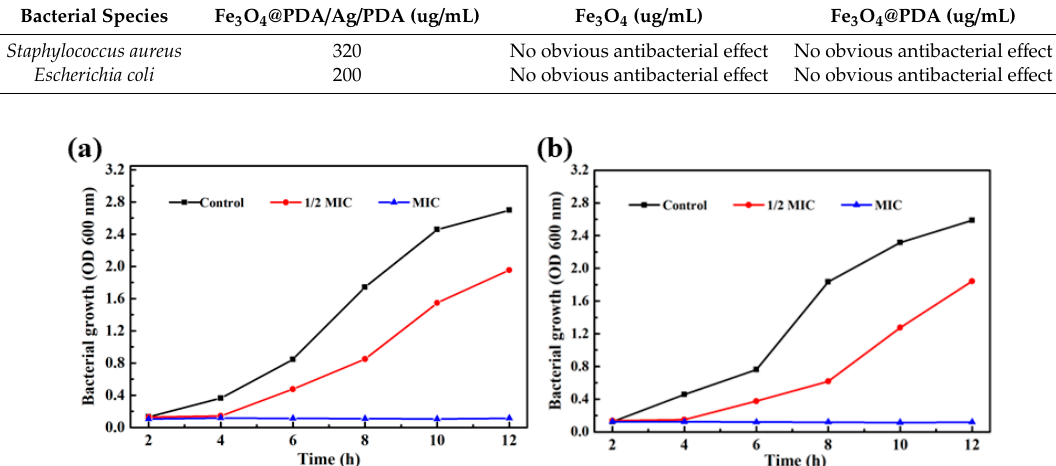
Table 1. Minimum inhibitory concentration (MIC) of the samples.